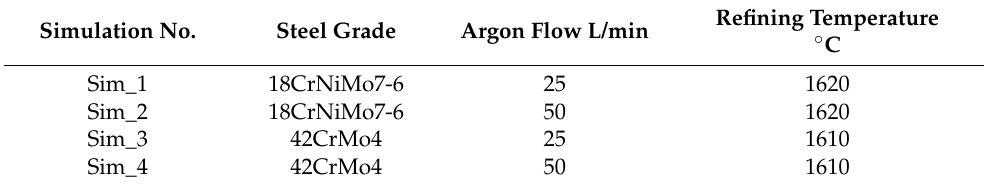
Table 3. Numerical simulation